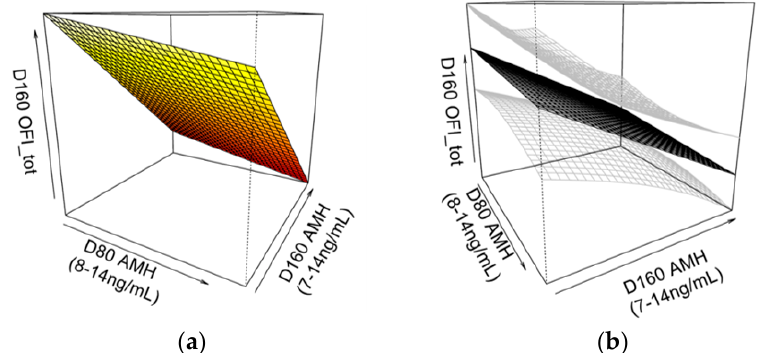
Figure 5. A three-dimensional smoothing spline model showing ( a ) the two-way interaction effect between serum anti-Müllerian hormone (AMH) levels at 80 (D80) and 160 days of age (D160) on OFI tot in non-cycling gilts at D160 ( p = 0.045, Adj-R 2 = 0.12). This relationship is also shown ( b ) with standard errors (in grey), rotated for perspective. Pubertal status was determined by the presence of corpora lutea at D160. Non-cycling gilts with both lower D80 and D160 AMH levels had greater OFI tot values. Greater OFI tot values correspond to gilts with greater overall follicle counts (primary, secondary, preantral, antral and atretic).